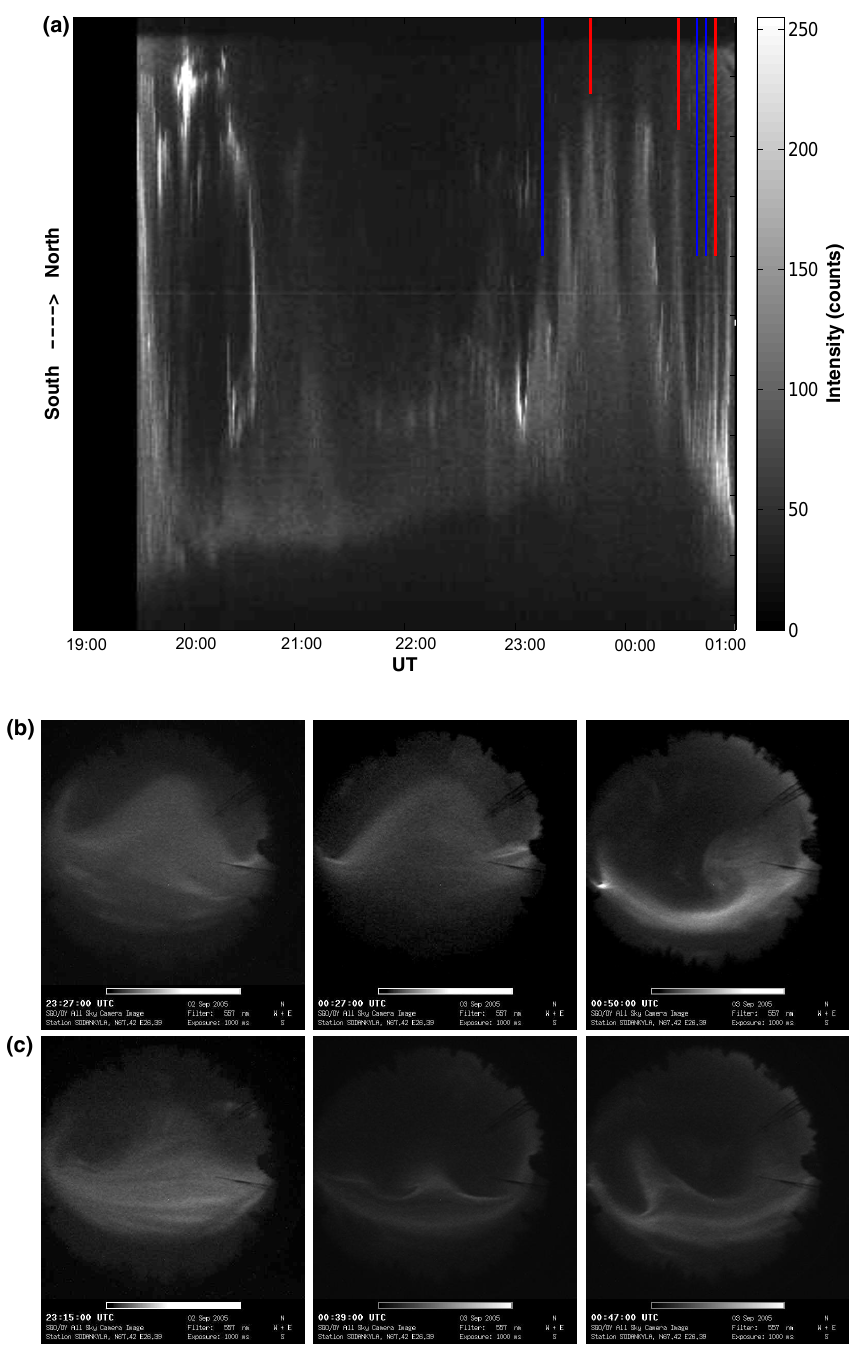
Figure 1. Keogram from SOD station on the night of 2 September in 2005 (a) . The y axis is the zenith angle of the images from south (bottom) to north (top) and the x axis is UT in hours. The intensity is in relative brightness units (counts from 0 to 255). At 23:00–01:00UT the auroral boundary undergoes undulations which show up as wave-like features in the keogram. Three selected omega structures are shown in the middle panel images (b) taken at 23:27, 00:27 and 00:50UT. The red vertical lines on the keogram mark the individual omega forms in (b) . Examples of less-obvious omega structures at 23:15, 00:39 and 00:47UT are shown in (c) and marked by blue vertical lines in the keogram. The contrast in all images is